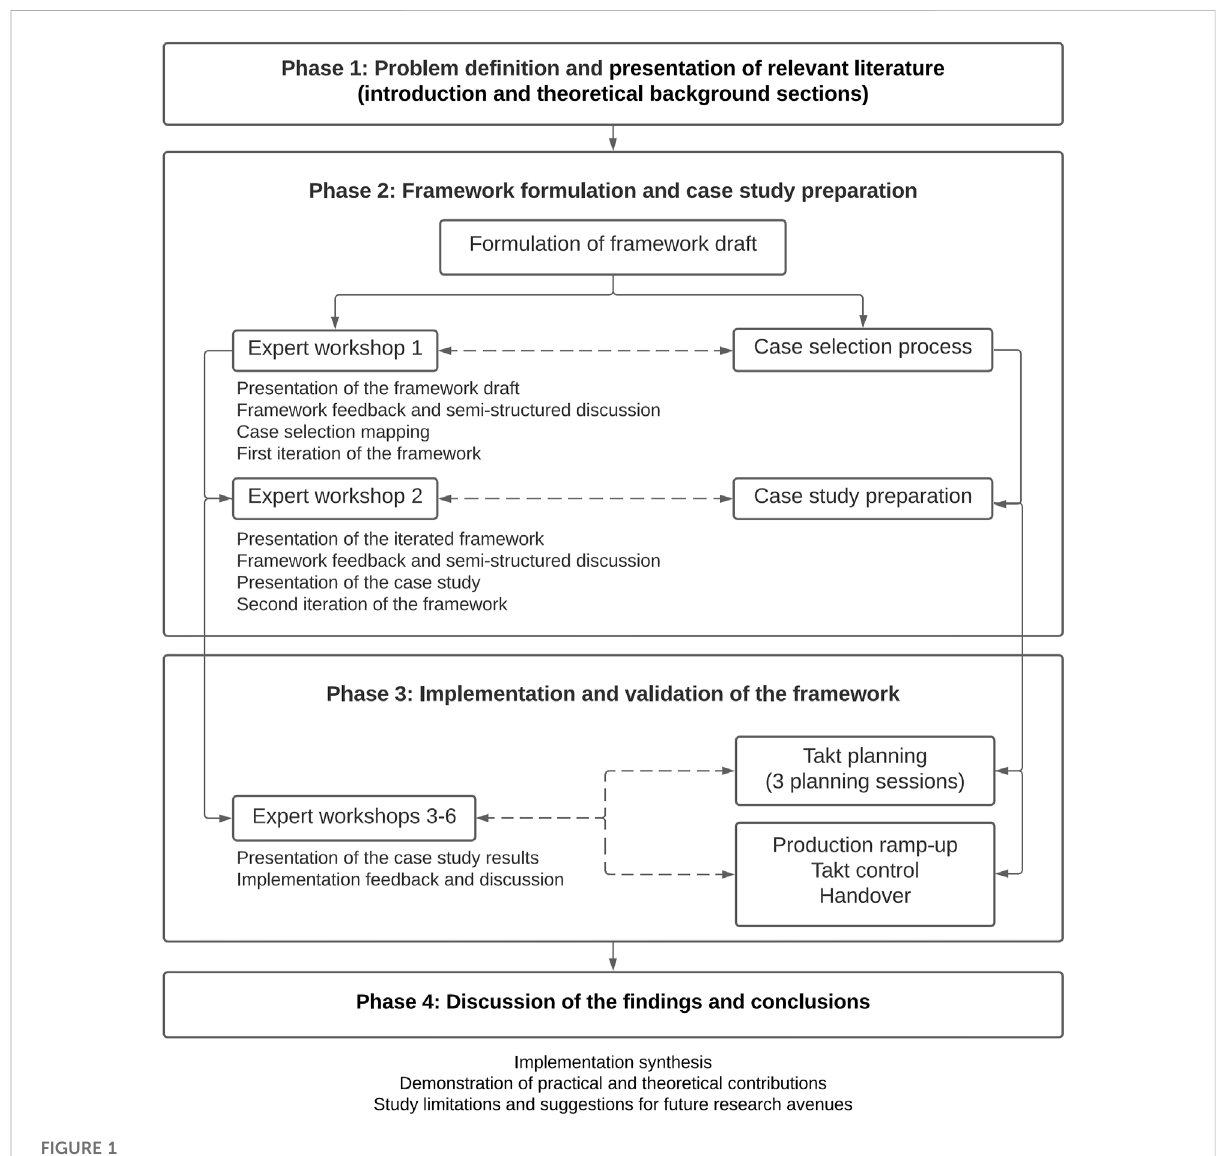
FIGURE 1 The fl ow of the